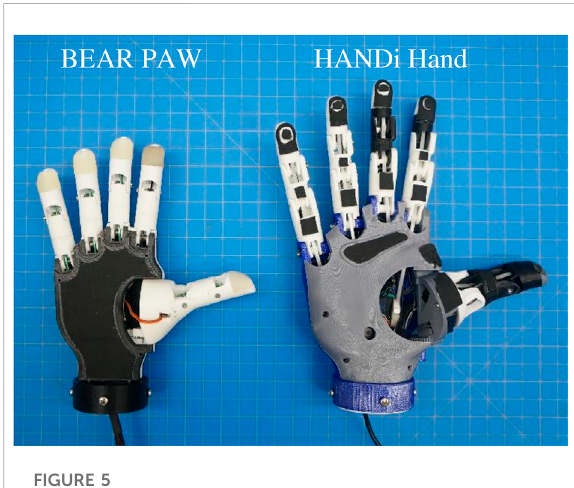
FIGURE 5 A size comparison between the BEAR PAW, a pediatric prosthetic hand, and the HANDi Hand, an adult prosthetic hand. Left shows the BEAR PAW and right shows the HANDi Hand. Each square in the background is 1 cm by 1